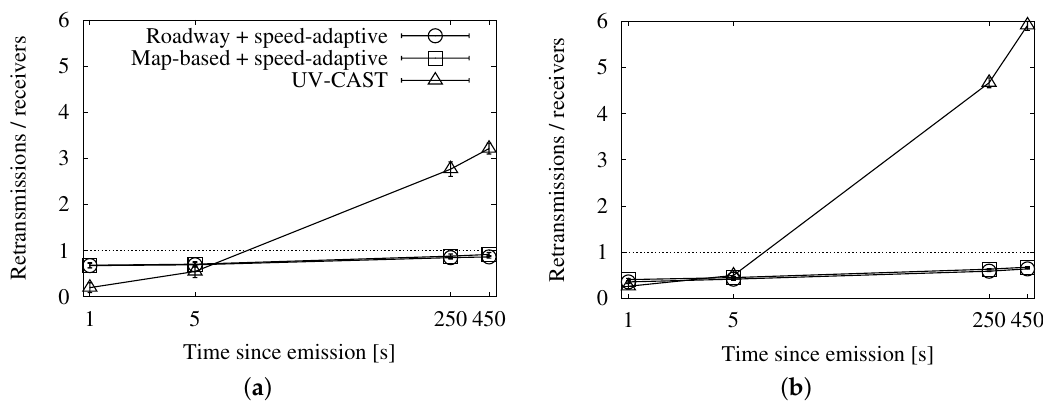
Figure 18. Forwarding ratio or the relation between sent messages and receivers in comparison with UV-CAST in the New York scenario: ( a ) 25 vehicles/km 2 ; ( b ) 100 vehicles/km 2